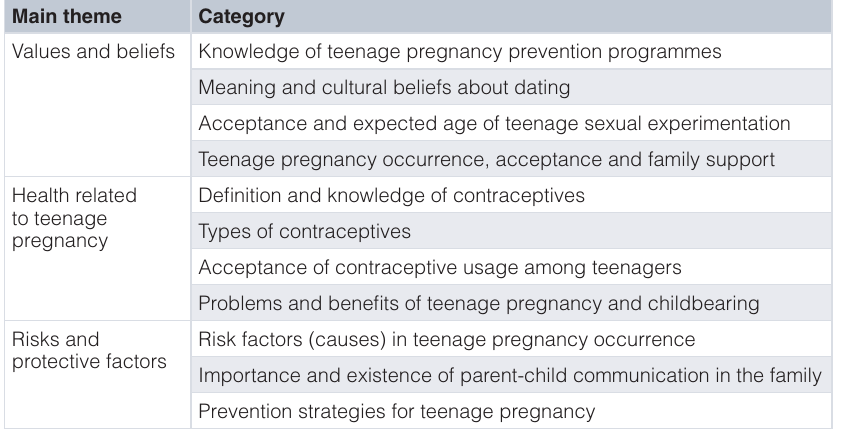
Table 2. Main themes and categories generated from the